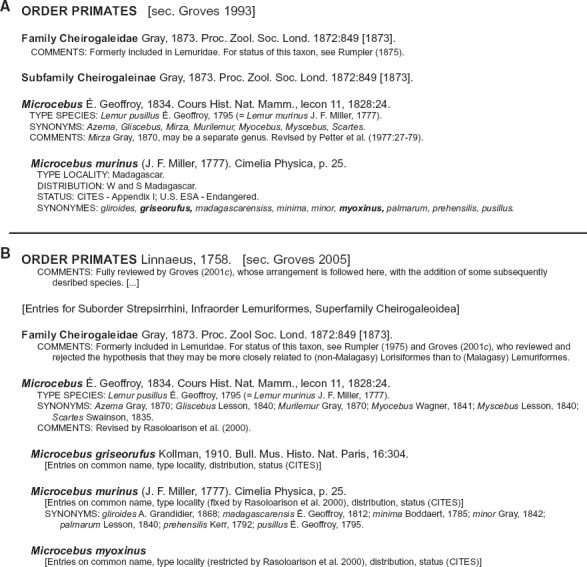
Representation of taxonomic concept entries in the second and third editions of the Mammal Species of the World series (Wilson and Reeder 1993, 2005). A) Concept sequence from Primates to Microcebus (in part) sec. Groves (1993) (MSW2: 243). B) Concept sequence from Primates to Microcebus (in part) sec. Groves (2005) (MSW3: 111–113) (several intermediately ranked concepts omitted). Nine synonymous names are listed under Microcebus murinus sec. Groves (1993). Of these, seven are congruently listed under Microcebus murinus sec. Groves (2005). However, phenotypes referred to as Microcebus griseorufus and Microcebus myoxinus (listed in bold italics in A) are treated differentially across treatments, acquiring separate species-level concept status from Microcebus murinus sec. Groves (2005) in the MSW3 edition. Accordingly, we can specify the articulations (in abbreviated annotation): (i) 2005.Microcebus_griseorufus < 1993.Microcebus_murinus; (ii) 2005.Microcebus_murinus < 1993.Microcebus_murinus; and (iii) 2005.Microcebus_myoxinus < 1993.Microcebus_murinus. See also Figure 1.